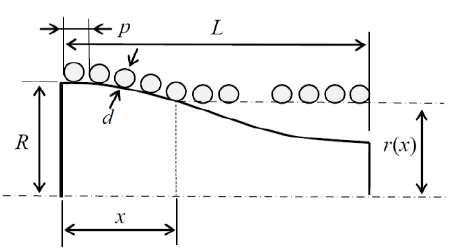
Figure 4. Model of the guide-shaft.